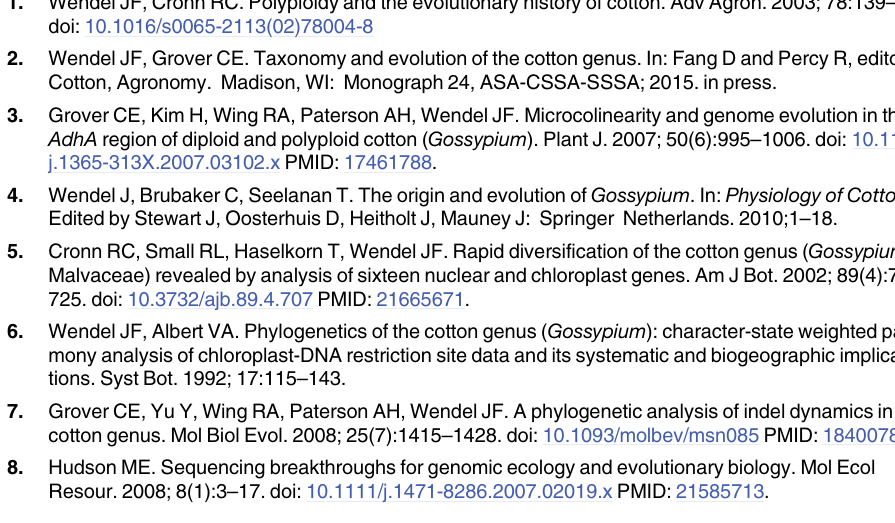
S8 Table. Calibrations with fossil taxonomic information, fossil age and references.